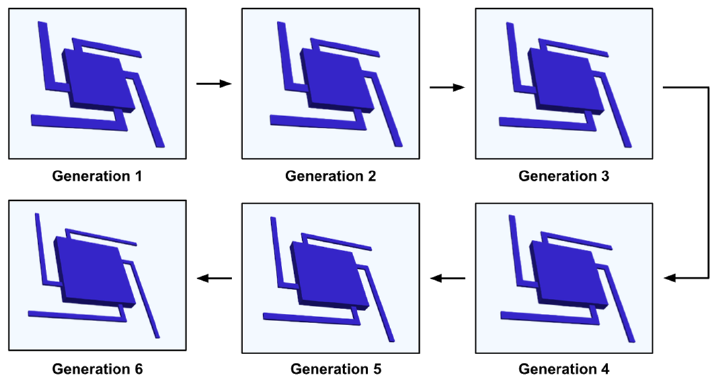
Figure 7. Evolution of the MEMS accelerometer through the 6 generations optimization of the GA. After 6 generations, the suspension beam width is reduced and the proof mass is enlarged.